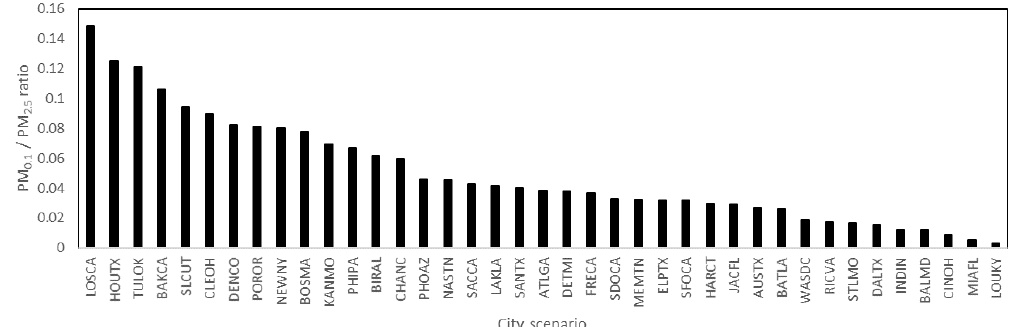
Figure 11. PM 0 . 1 / PM 2 . 5 ratio for each city.